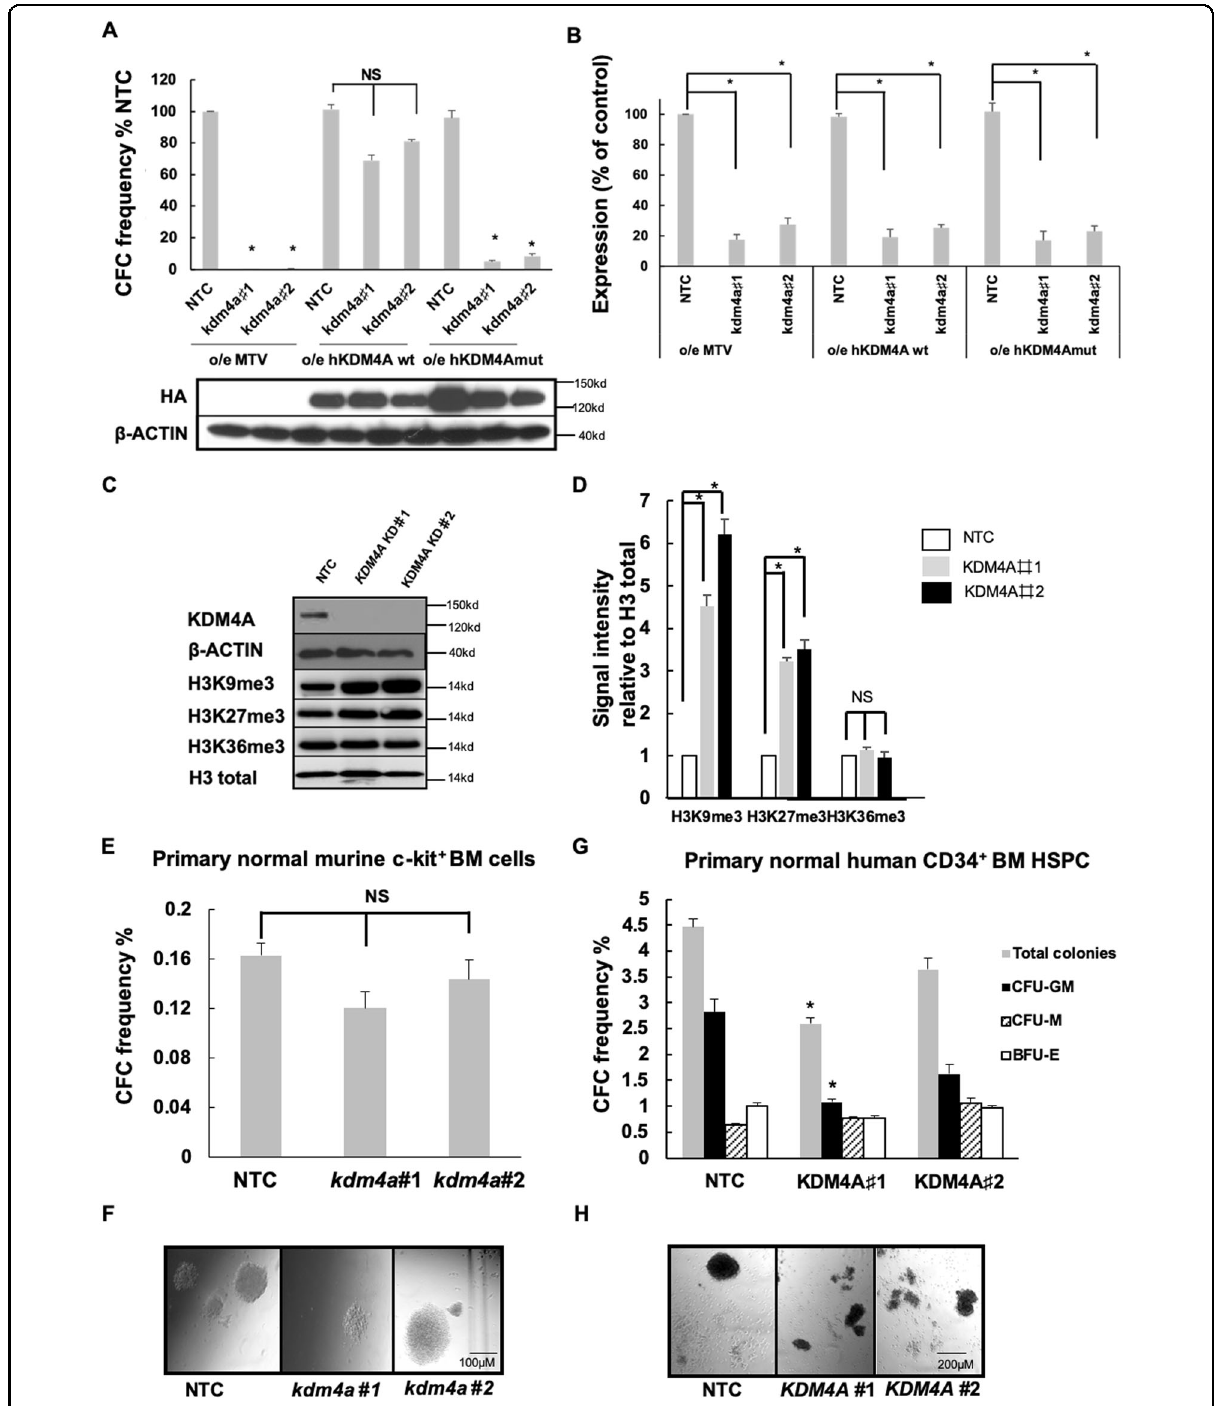
Fig. 2 Targeting KDM4A ’ s demethylase activity inhibits AML cell proliferation. A CFC frequencies for control and kdm4a KD cells from the indicated murine MLL-AF9 cells overexpressing empty vector (MTV) or wild-type human HA-tagged-KDM4A or an enzymatically inactive mutant of human HA-tagged- KDM4A (KDM4Amut H188A/E190A) ( n = 3); * p <0.001, NS p >0.05. Representative immunoblot below bar plot shows the overexpression of wild type (wt) and mutant (mut) human HA-tagged KDM4A in correlated MLL-AF9 cells labeled, detected by HA antibody. B Bar chart showing mean±s.e.m. an expression of kdm4a by QPCR in kdm4a KD cells from ( A ) relative to NTC in murine MLL-AF9 leukemic cells ( n = 3); * p <0.01. C Representative immunoblots with indicated antibodies showing expression of indicated proteins in THP1 cells 72h following initiation of KDM4A KD ( n = 3). D Immunoblot quanti fi cation of signal intensity relative to H3 total from C . E – H The indicated primary human and murine AML cells were transduced with lentiviruses targeting KDM4A or kdm4a for KD, or an NTC. All bar charts show mean±s.e.m. CFC frequencies of ( E ) primary normal murine c-kit + BM cells for NTC and kdm4a KD ( n = 3) or ( G ) primary normal human CD34 + HSPC cells for NTC and KDM4A KD cells ( n = 3); * p <0.01. F and H are representative images from ( E ) and ( G ), Scale bar represents 100µm and 200µm,